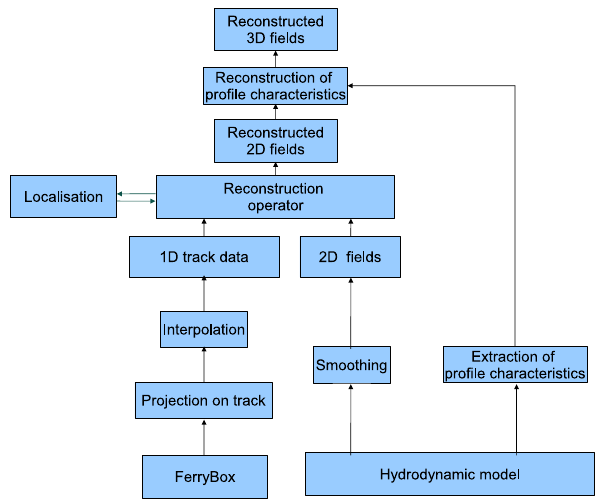
Fig. 13. Data flow diagram and operations used for reconstruc- F IG . 13. Data flow diagram and operations used for reconstruction of 3D temperature and tion of 3-D temperature and salinity fields from FerryBox measure- salinity fields from FerryBox measurements.